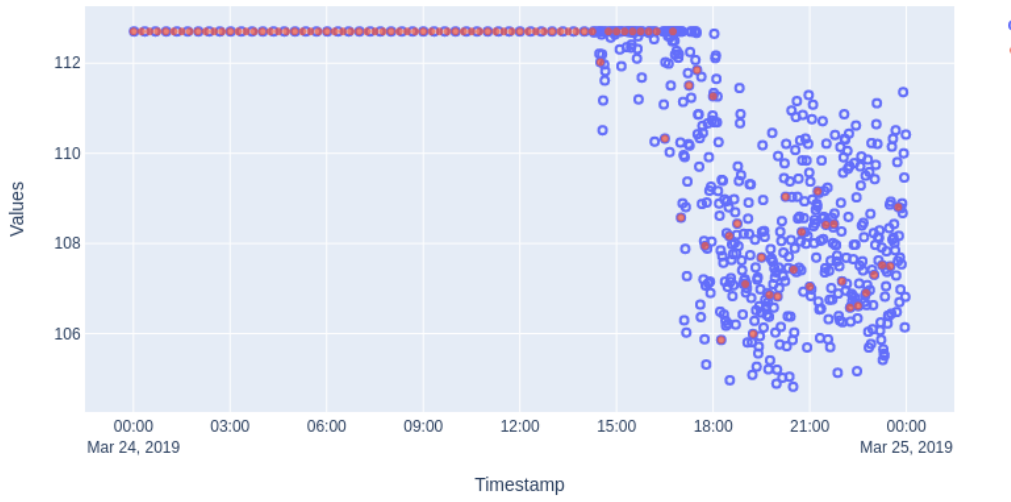
Figure 12. Comparison between original time series and after the use of smart join for the feature with id